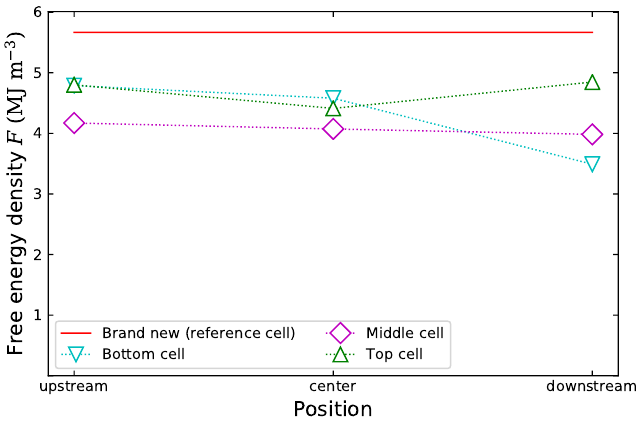
Figure 6. Comparison of the total average free energy density in samples from cells after degradation to the total free energy in samples from a brand new (reference)